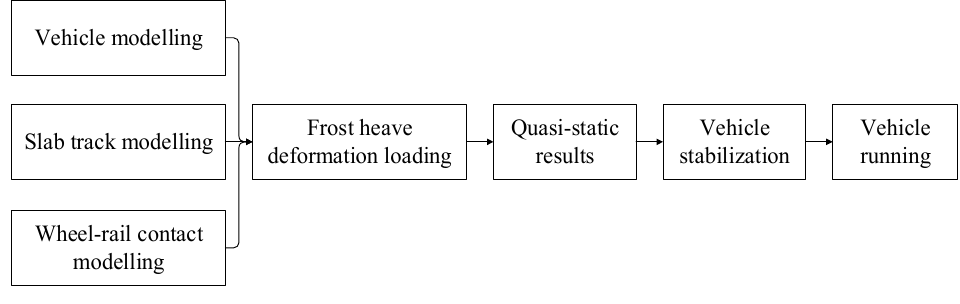
Figure 6. Analytical concept of Model-C.